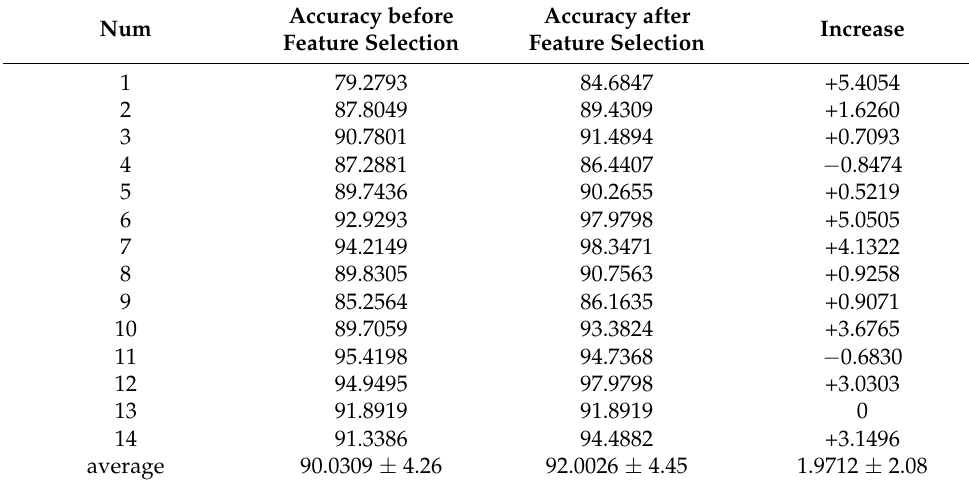
Table 7. Comparison of classification accuracy before and after feature selection.